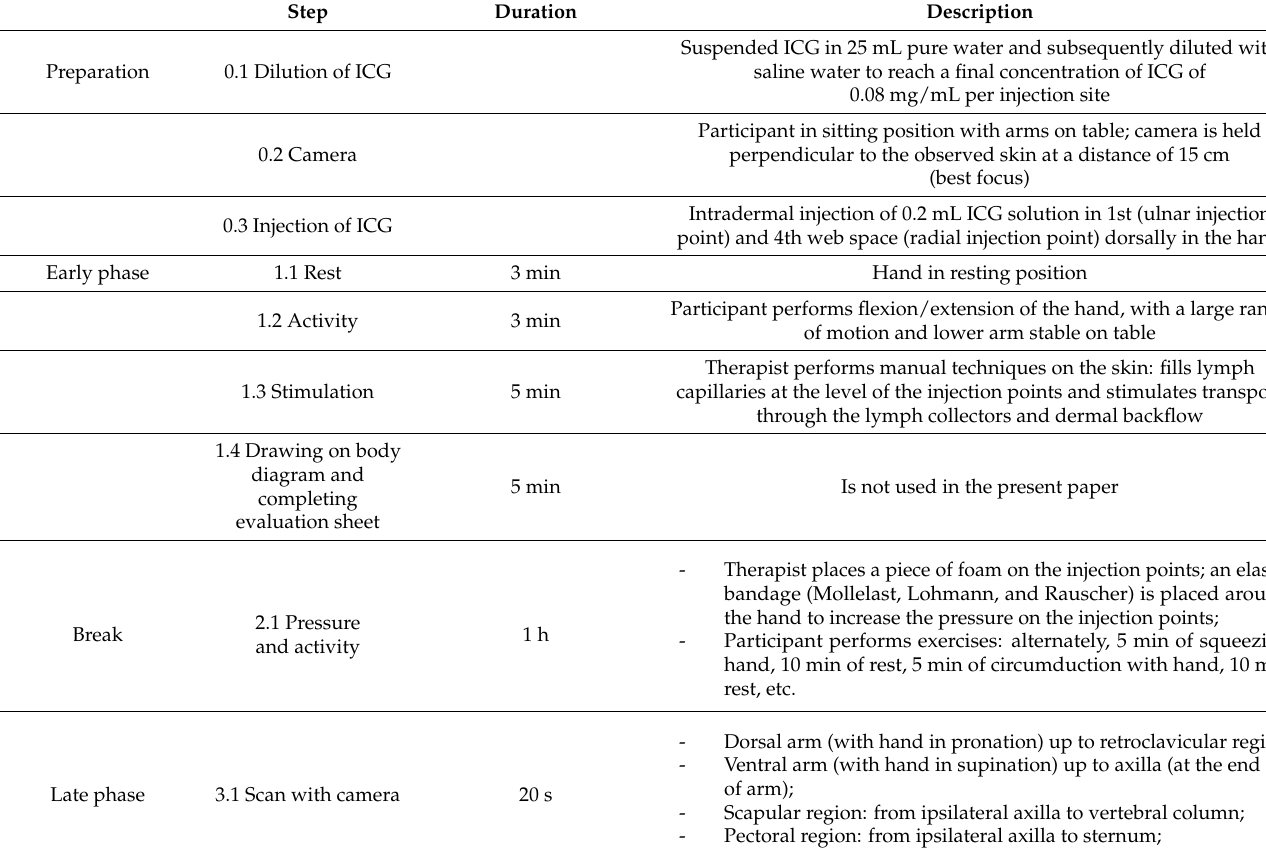
Table 2. Protocol of lymphofluoroscopy and the procedure to determine the different